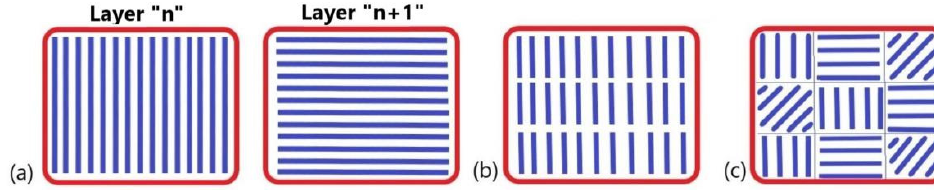
Figure 1. Laser scanning strategies: ( a ) X / Y alternating scanning; ( b ) Stripe hatch pattern; ( c ) Chessboard hatch pattern (or islands).